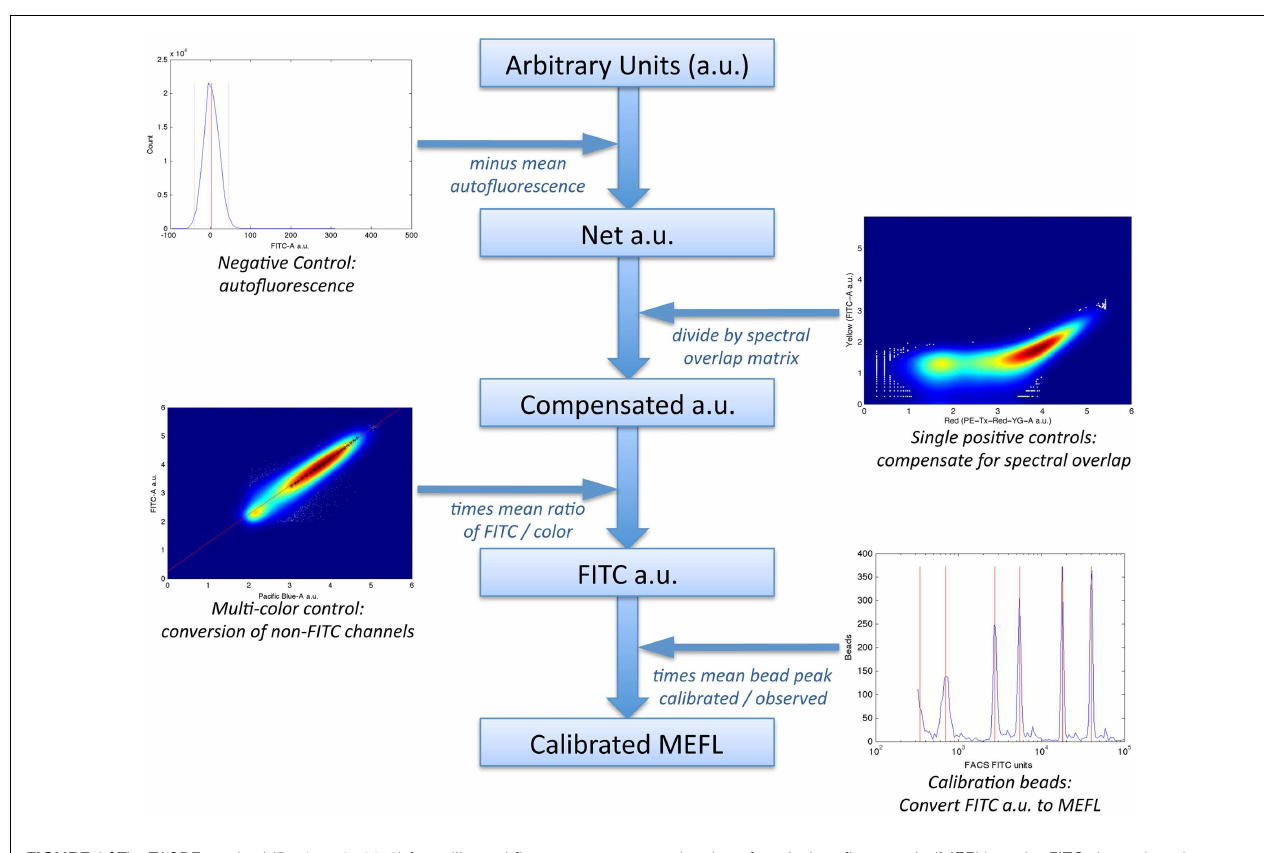
FIGURE 6 | TheTASBE method (Beal et al., 2012) for calibrated flow cytometry uses four controls: correction for autofluorescence and spectral overlap is computed from the negative and single-positive controls. Calibration beads provide a conversion from arbitrary units to